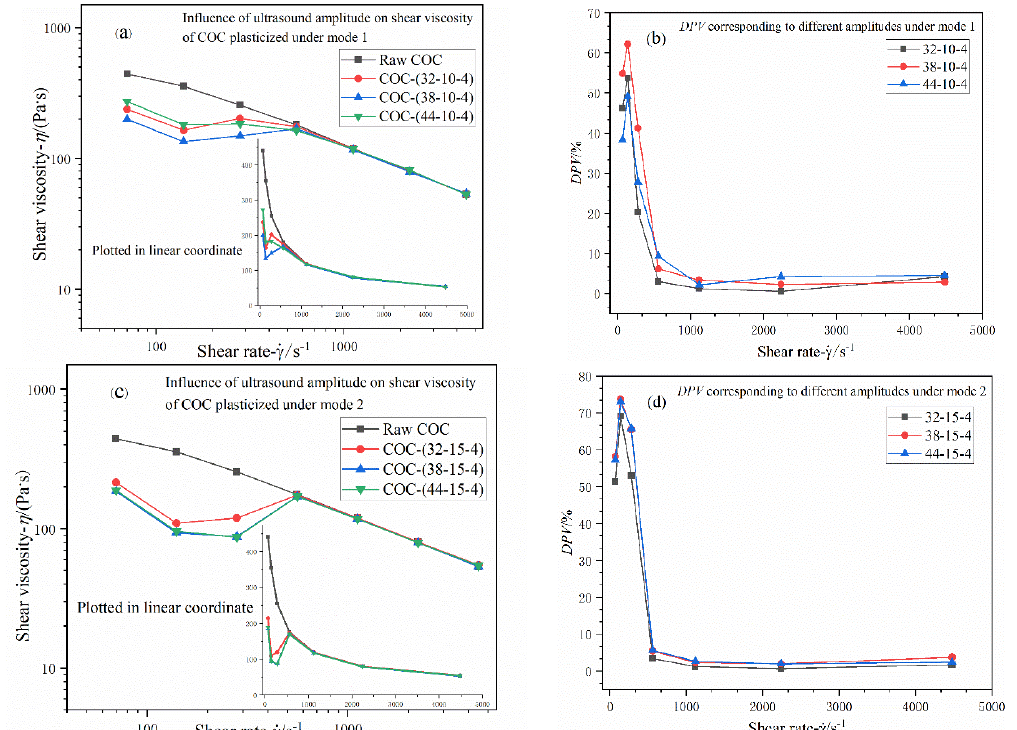
Figure 7. ( a , c ) Influence of adjusting ultrasound amplitude on shear viscosity of COC plasticized under Mode 1 and Mode 2; ( b , d ) DPVs corresponding to di ff erent ultrasound amplitudes under two di ff erent modes. Nomenclature: ultrasonic amplitude ( µ m); plasticizing pressure (MPa); ultrasonic action time (s).